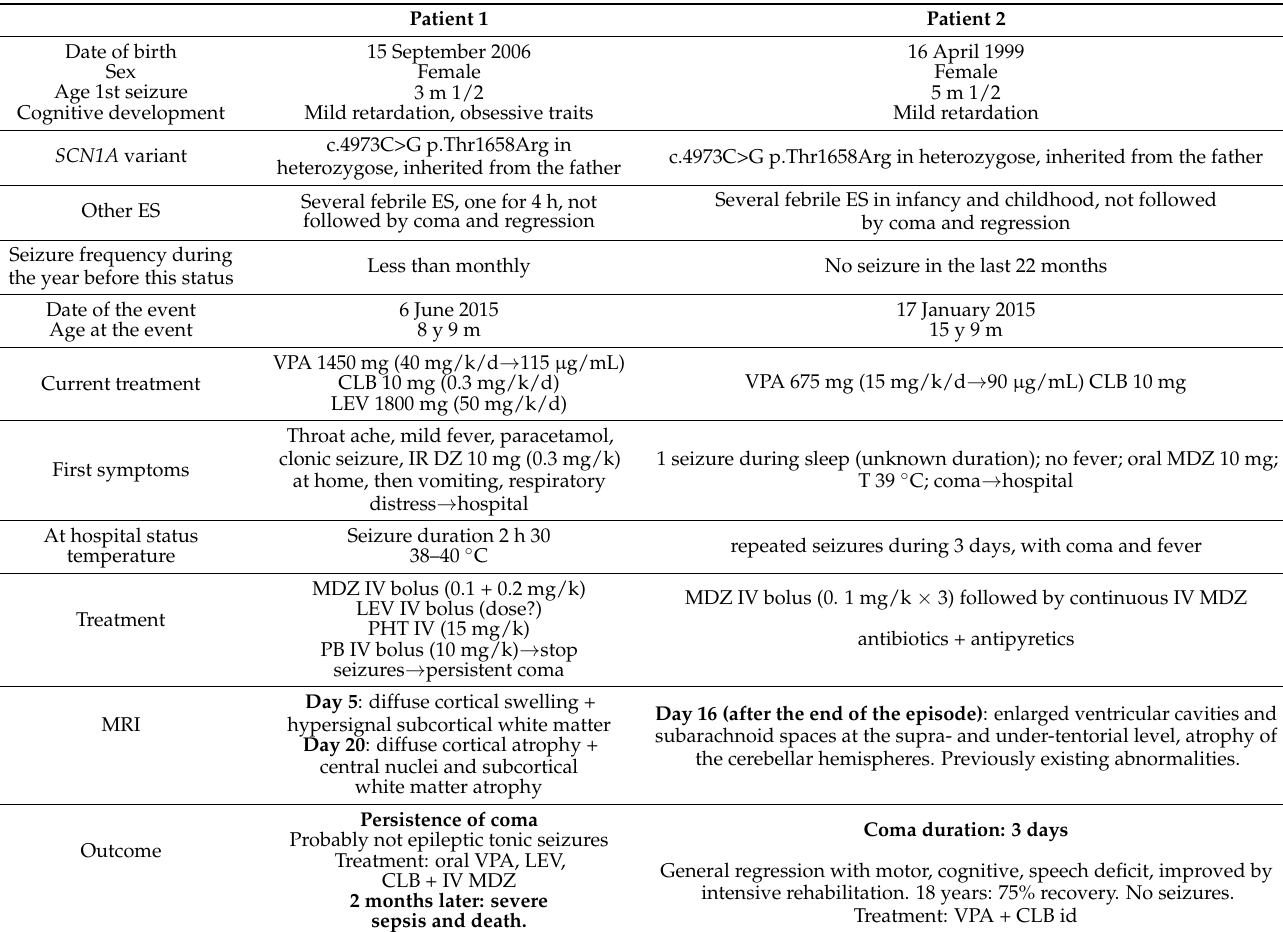
Table 1. Data of the two